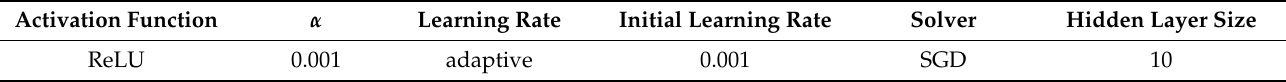
Table 4. Hyper Parameter Table of Tuned BP Network.